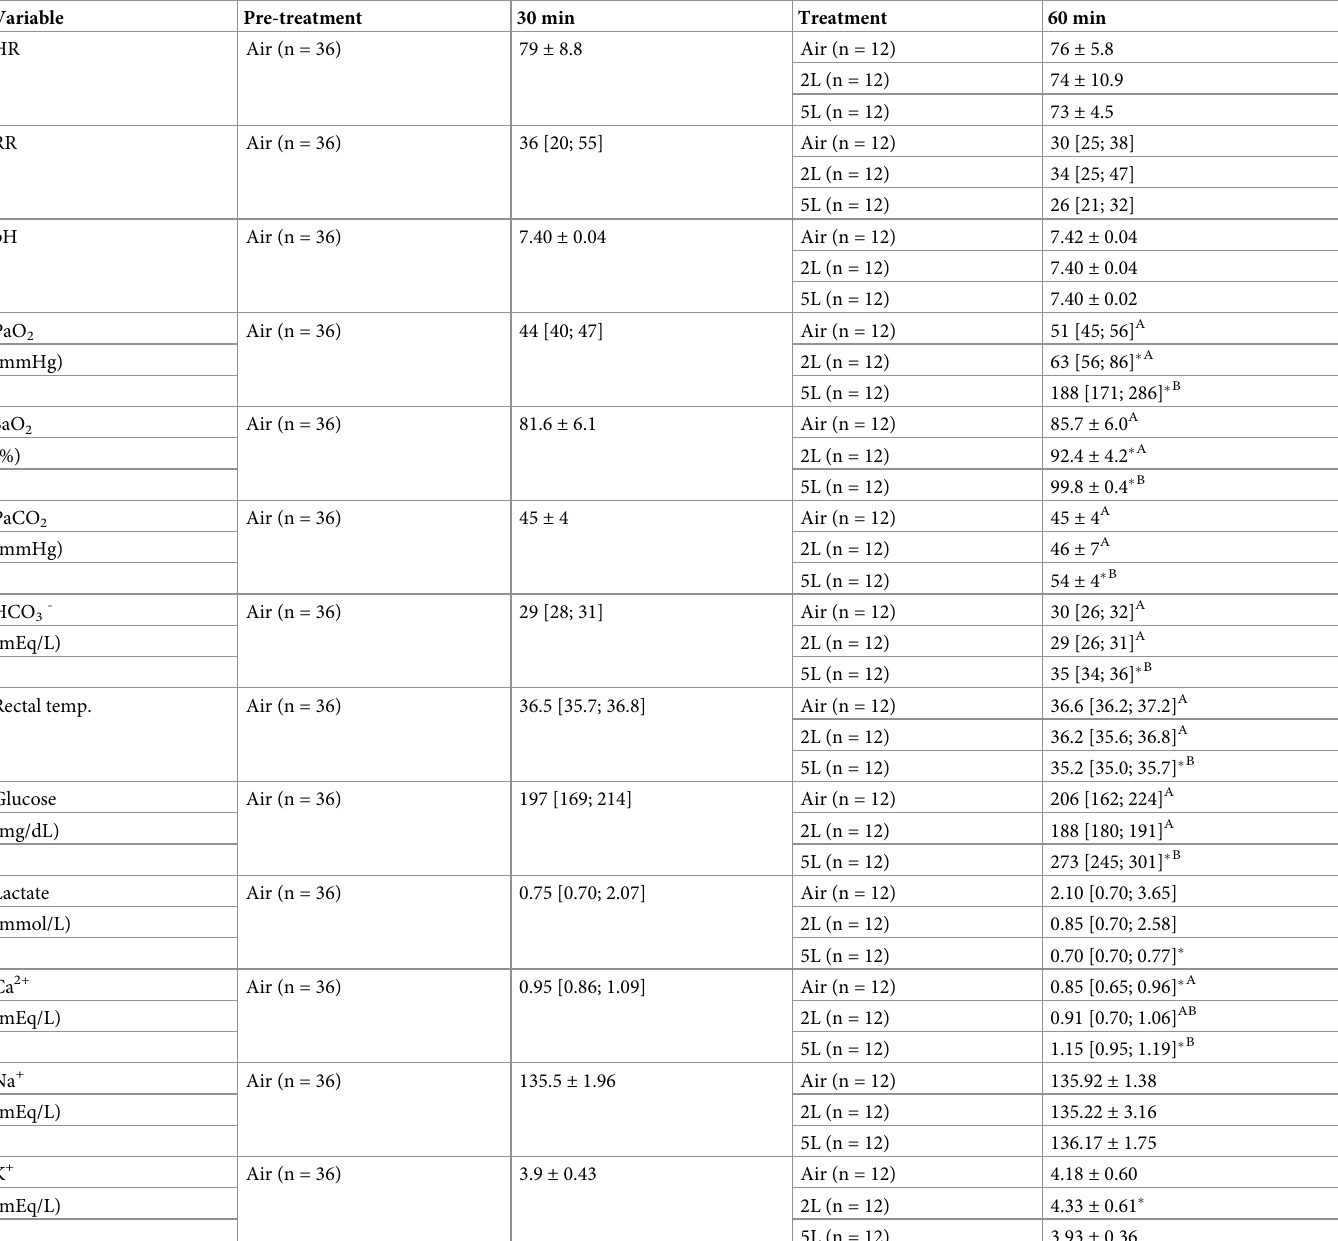
Table 1. Heart rate, respiratory rate, blood gas analysis, rectal temperature, glucose, lactate, plasma ionised calcium (Ca 2+ ), sodium (Na + ) and potassium (K + ) plasma concentrations in free-ranging capybaras ( Hydrochoerus hydrochaeris ) chemically restrained with dexmedetomidine and midazolam, and either